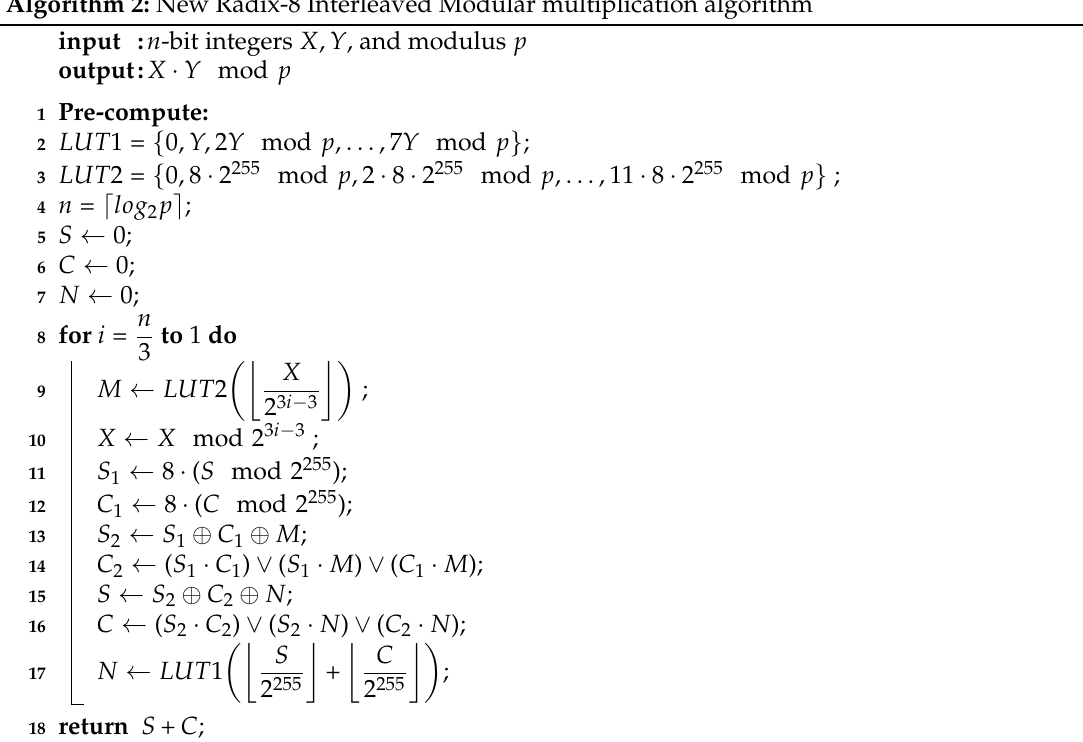
Algorithm 2: New Radix-8 Interleaved Modular multiplication